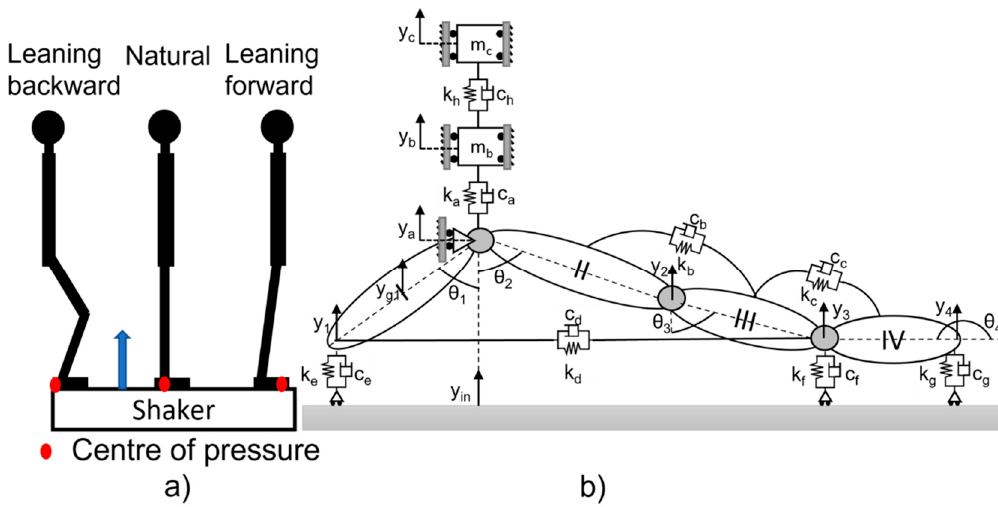
Figure 1. ( a ) Different body positions and the effect on the center of pressure [17]; ( b ) Six degrees-of-freedom model of the foot–ankle system composed of six rigid elements connected by Kelvin–Voigt models of stiffness ( k i ) and damping ( c i ) [12].